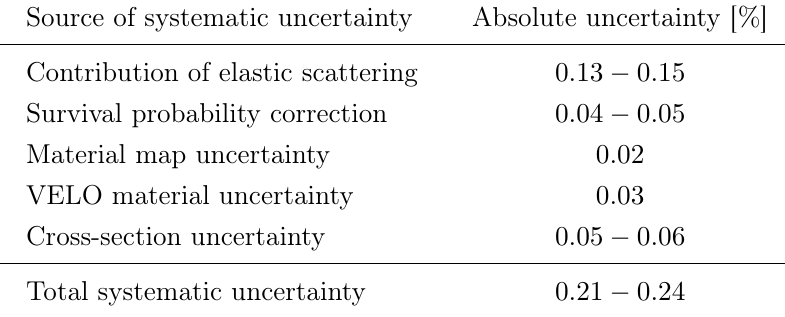
Table 2 . Ranges of the systematic uncertainties for the proton-detection